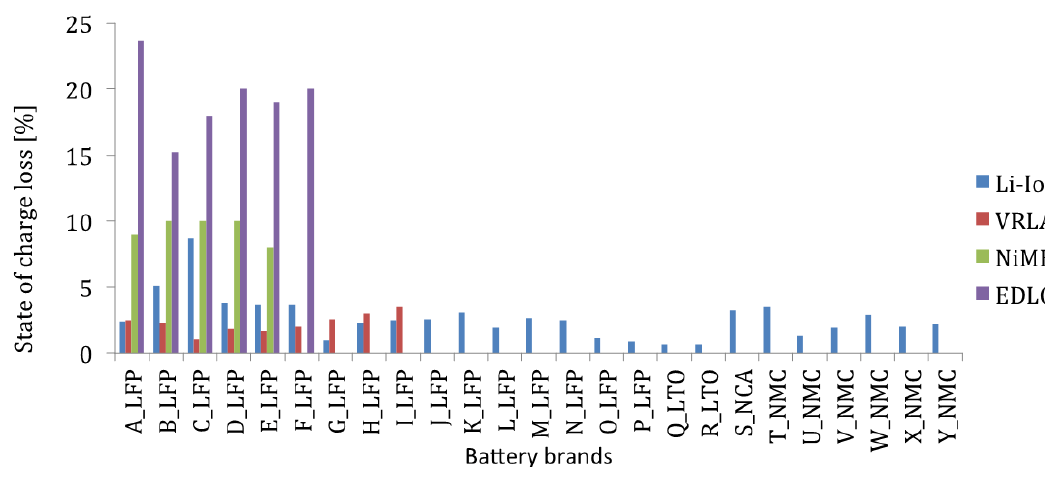
Figure 34. State of charge loss of various battery